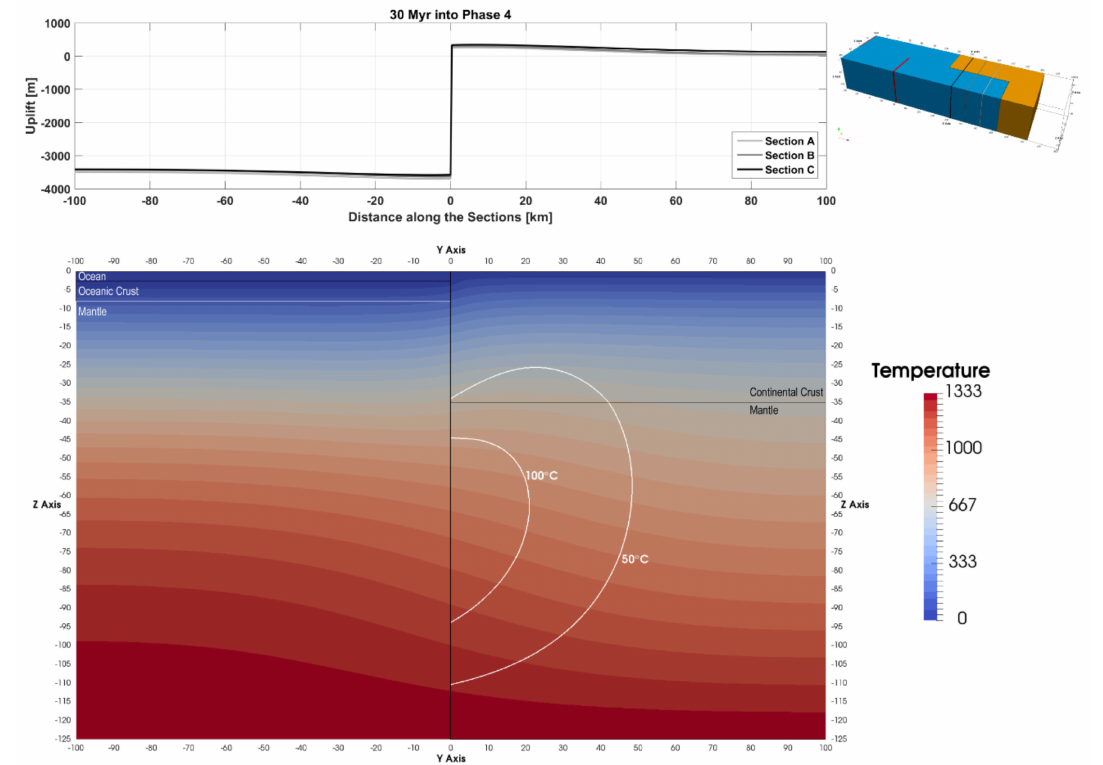
Figure 5. Thermal structure of the continental lithosphere along section A after 30 Myr in Phase 4 (35.5 Myr). The thermal anomaly (white contour) extends 48 km laterally into the continental lithosphere across the transform margin. The vertical central line denotes the transform margin. The lithosphere to the left of the margin is oceanic lithosphere with an age of 30 Ma. The excess temperature contours are restricted to the northern side of the transform margin. The upper left panel shows the corresponding uplift calculated along all the sections at 30 Myr into Phase 4. Note that all sections are 300 km east of the eastern ridge at this time. The upper right image shows the model configuration at 30 Myr into Phase 4 for Section